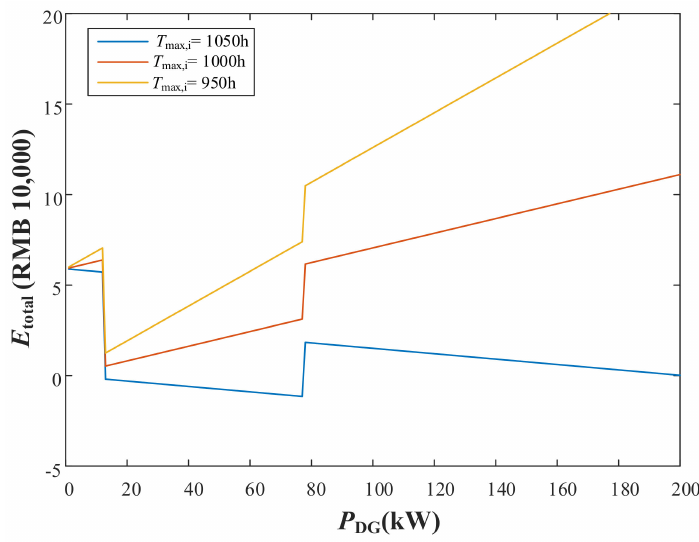
Figure 10. Change relation curve of E total with P DG